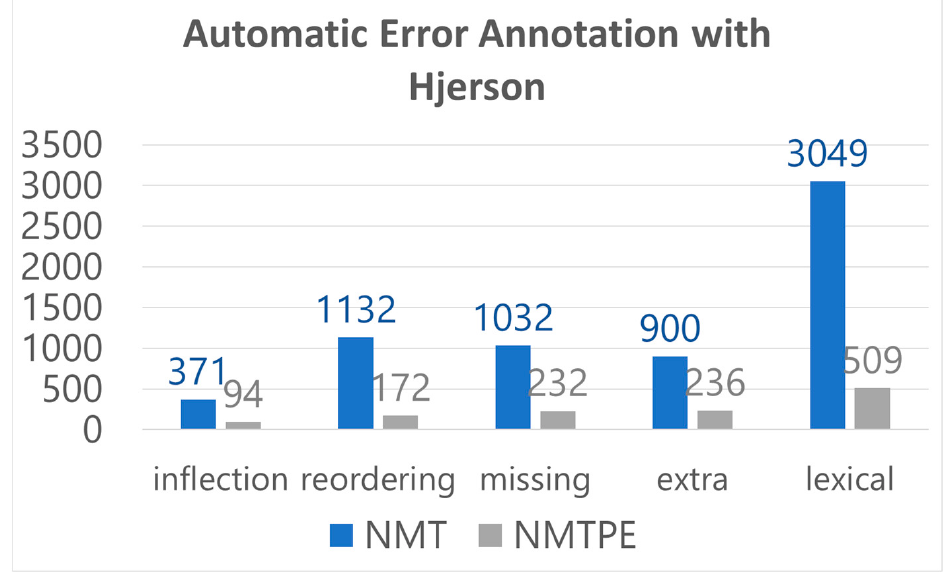
Figure 1. Raw Error Count after automatic annotation with Hjerson.